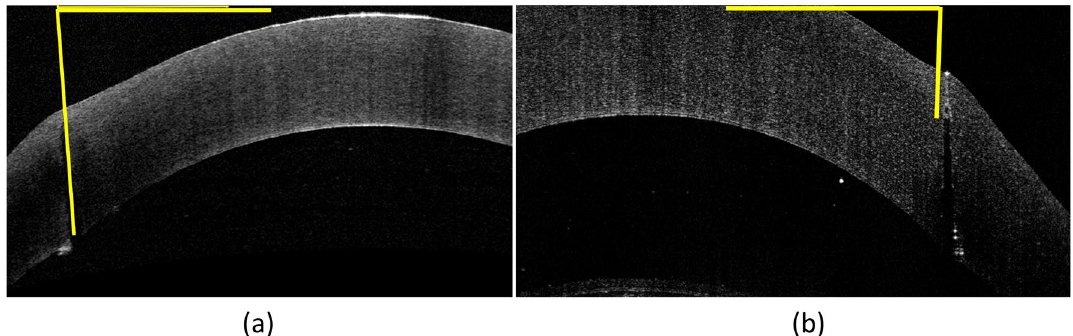
Figure 7. Post laser-cutting ASOCT images showing how the angles were measured. For the measurement of the laser cut angle, the first line was drawn in the horizontal plane of the image, and the second line was